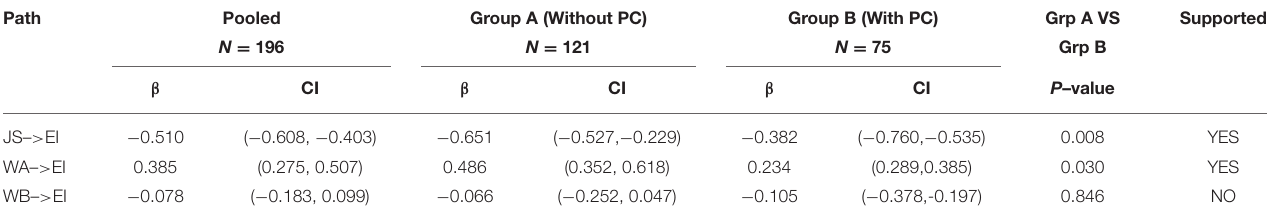
TABLE 9 | Multi–group analysis results.